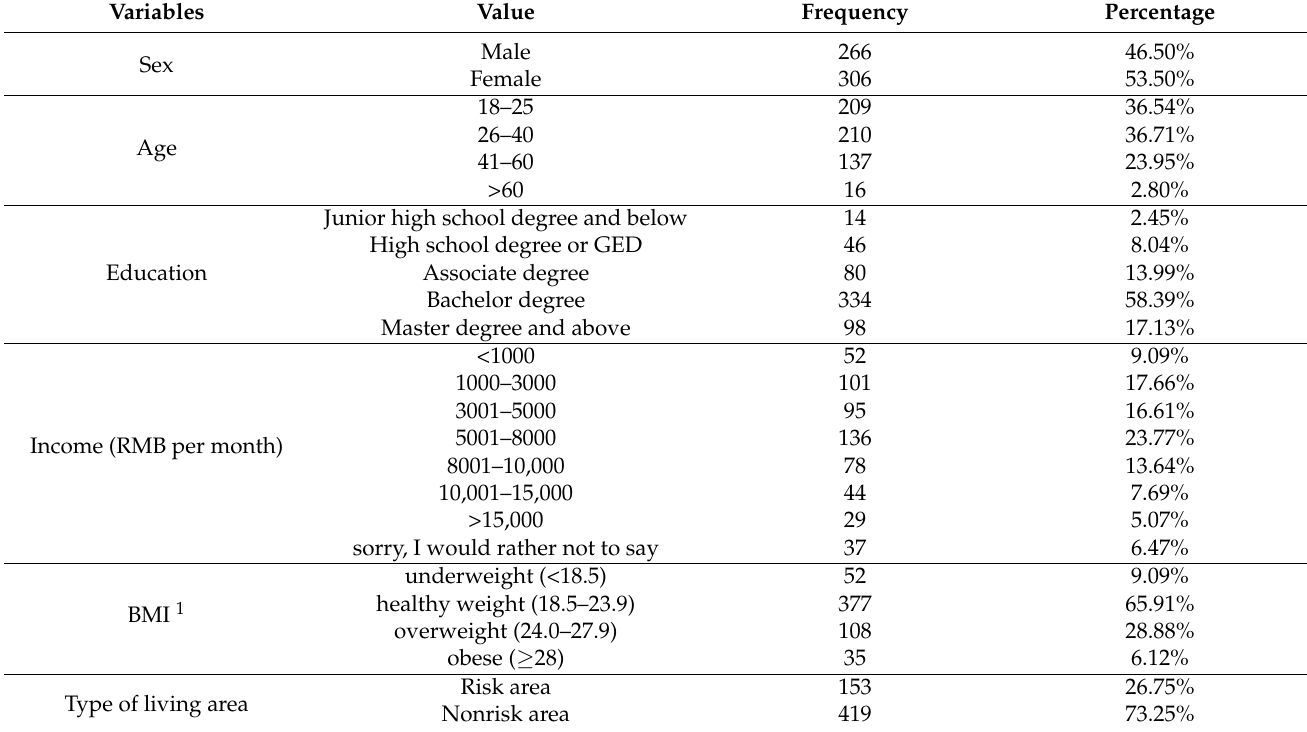
Table 2. Demographic information of the